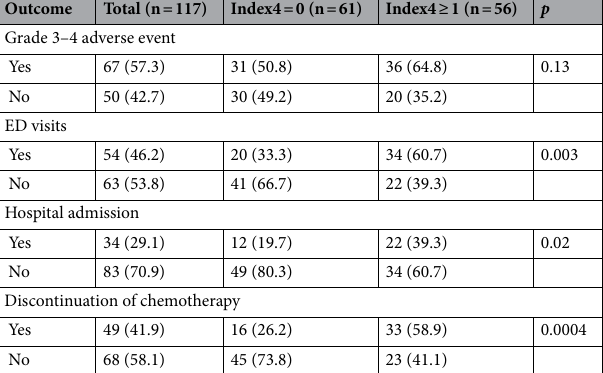
Table 3. Outcomes according to Index4. Percentages are in parentheses. ED Emergency Department.